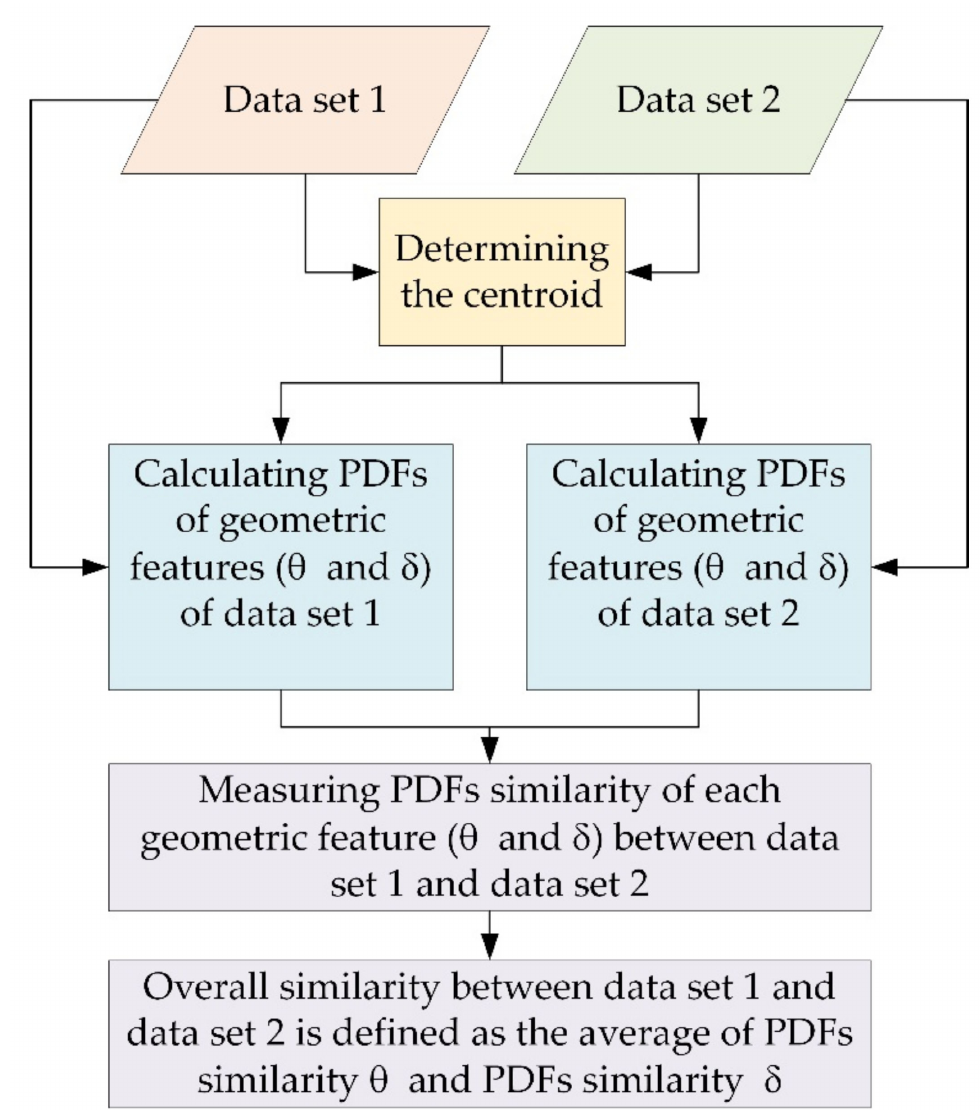
Figure 4. Overall workflow of the proposed method for measuring spatial and temporal pattern similarity between pairs of data